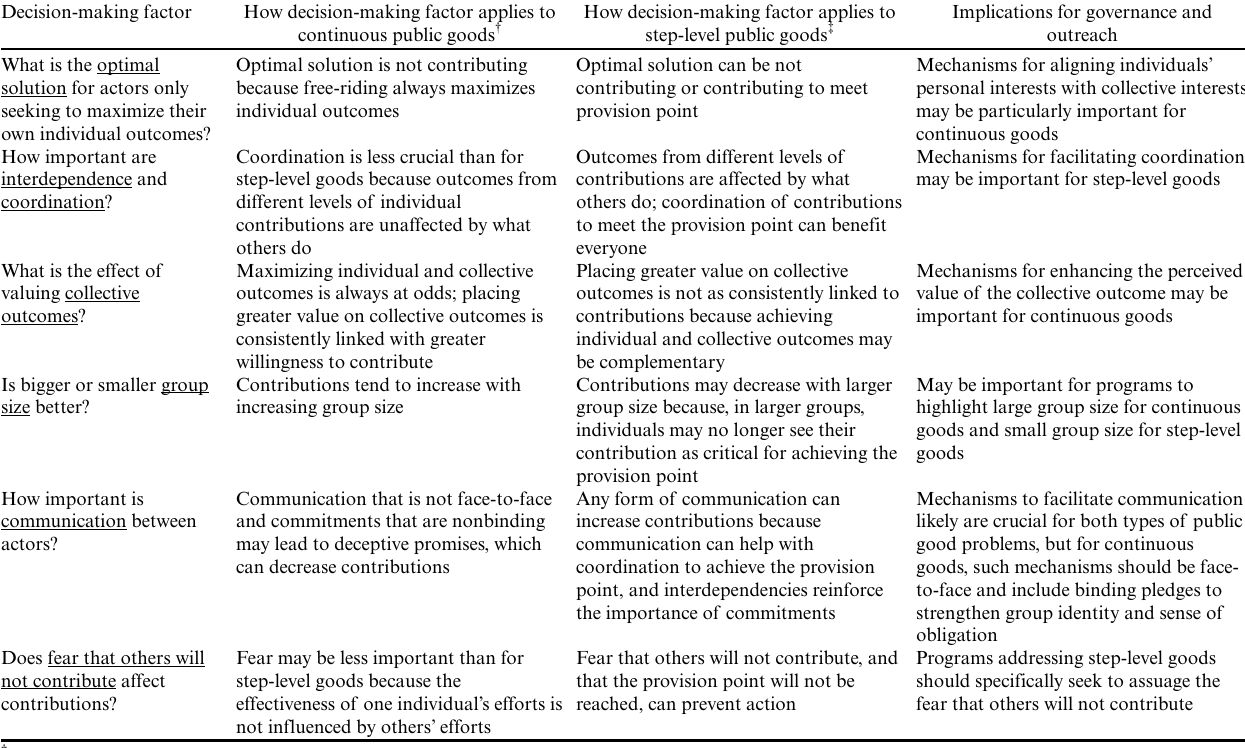
Table 1. A summary of how different factors may influence decision making for continuous vs. step-level public good scenarios and potential implications for governance. The table builds on the review of social dilemma laboratory-based experiments by Abele et al.